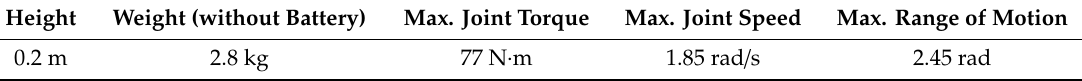
Table 1. Specifications of the powered geared five-bar (GFB) prosthetic knee.